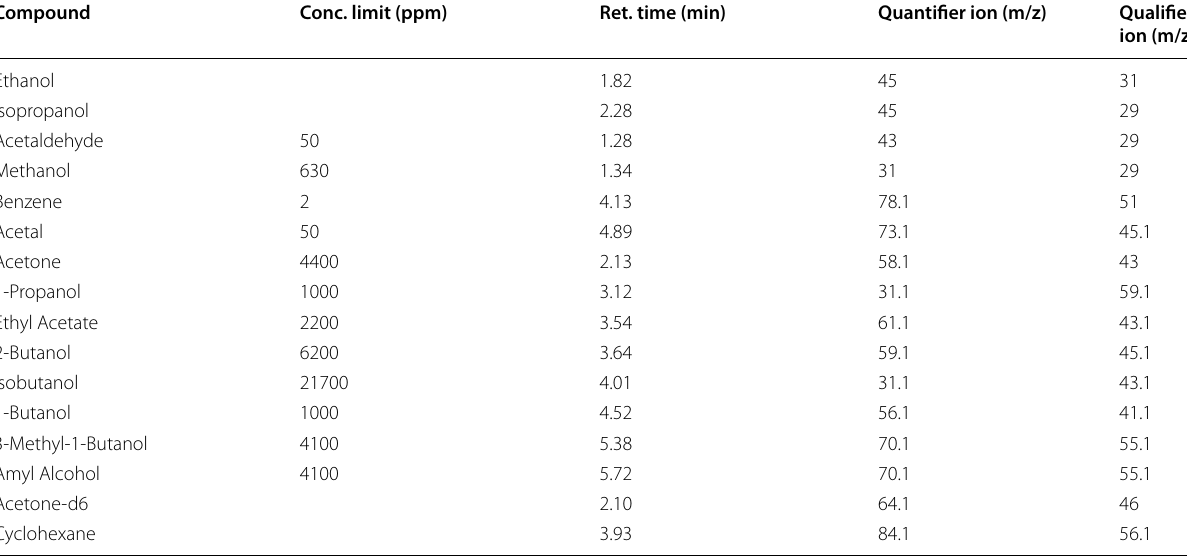
Table 1 Impurity limits and GC-MS conditions of active ingredients, impurities, and internal standards Compound Conc. limit